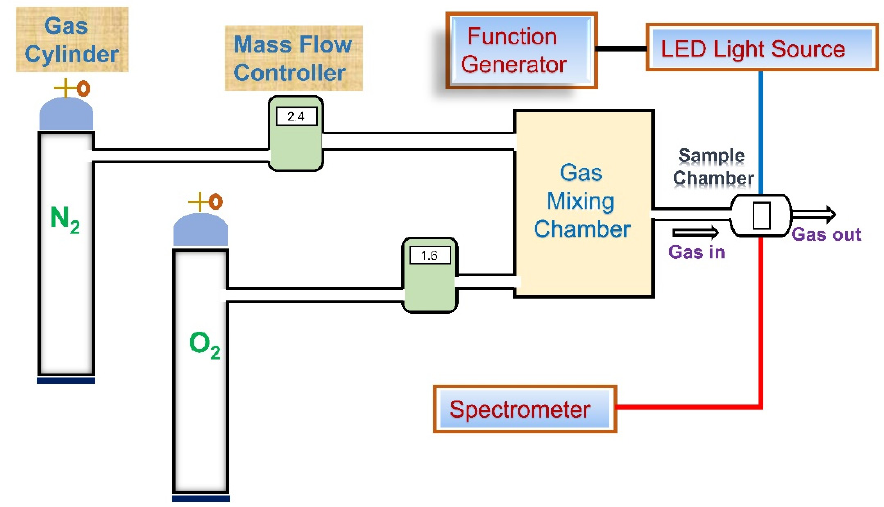
Figure 2. Schematic diagram of the setup for oxygen sensing measurements.